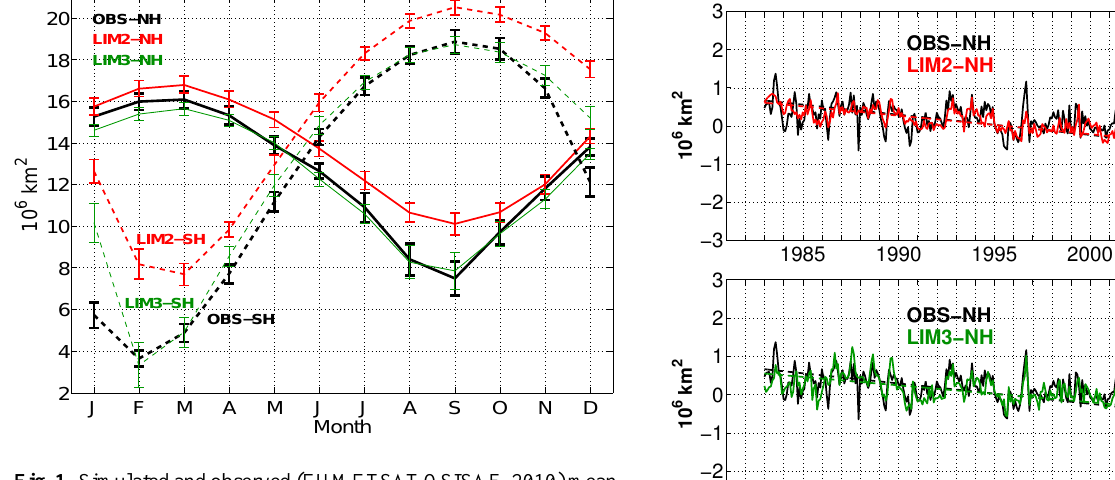
Fig. 1. Simulated and observed (EUMETSAT OSISAF, 2010) mean seasonal cycle of NH (solid lines) and SH (dashed lines) sea ice extent over the period 1983–2007. Extents are calculated as the total area of grid cells with concentration larger than 15%. The error bars denote the ± 1 σ deviation of monthly extents during the same period.